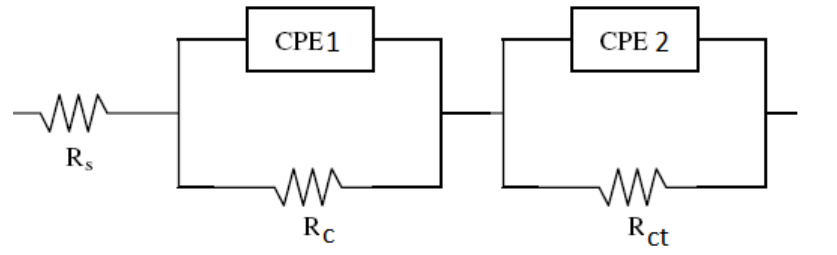
Figure 9. The equivalent electrical circuit.